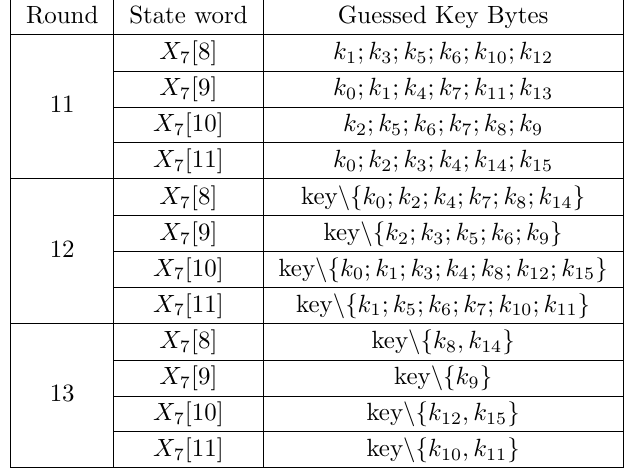
Table 3: Key bytes involved in X 7 [8] , X 7 [9] , X 7 [10] , X 7 [11] in the decryption